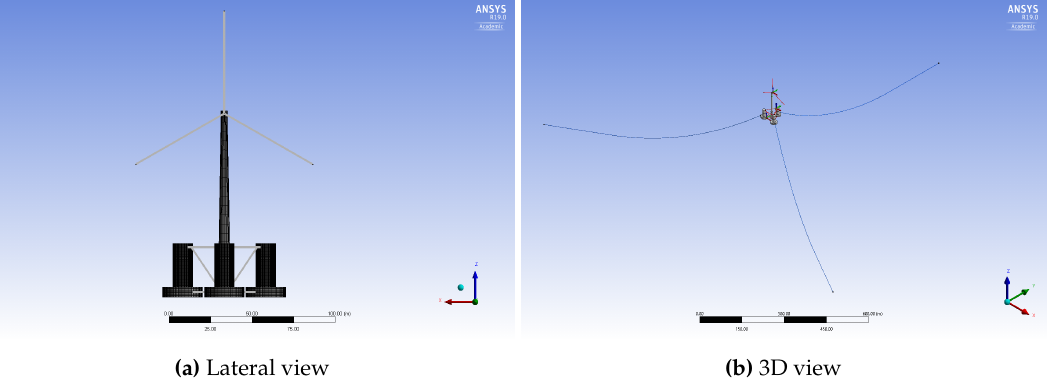
Figure 1. ANSYS R (cid:13) AQWA model lateral view and 3D representation. Table 1. Main characteristics of the 5 MW NREL structural model implemented in AQWA. Parameter Value Units Overall mass 1.389 × 10